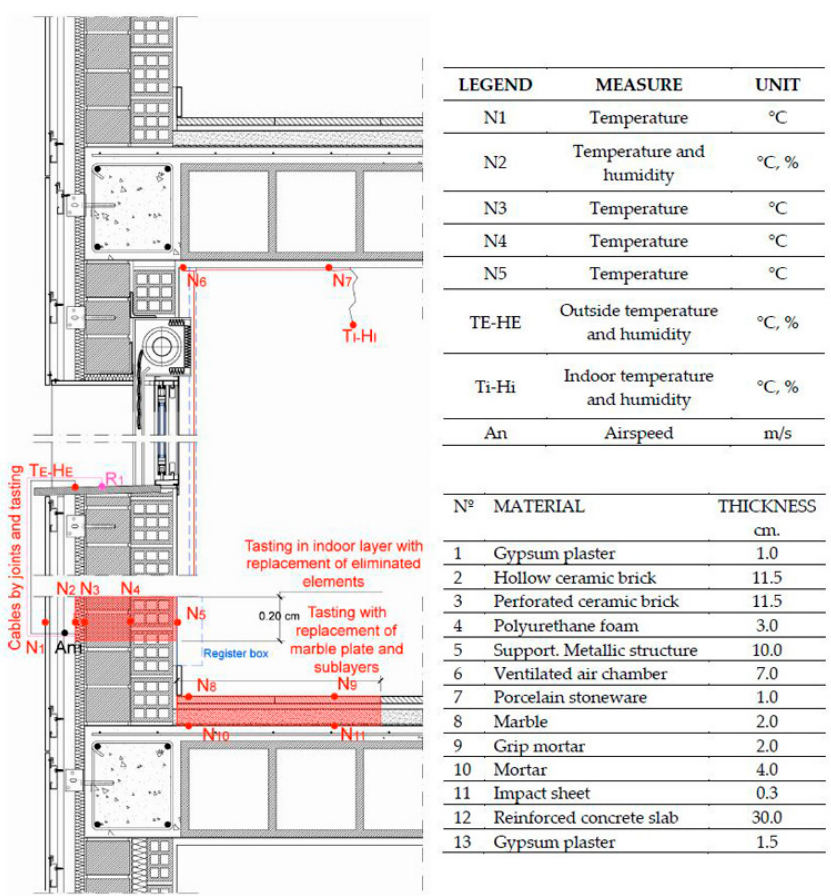
Figure 8. Chart of sensor locations.